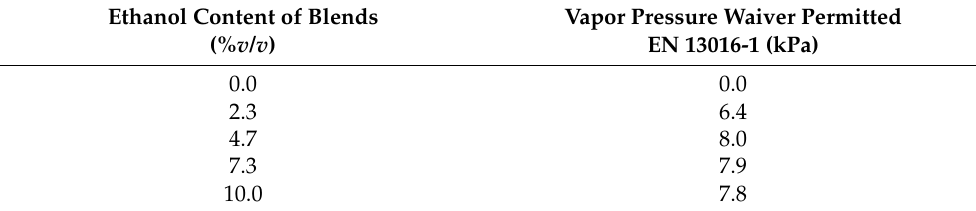
Table 6. Vapor pressure waiver permitted for